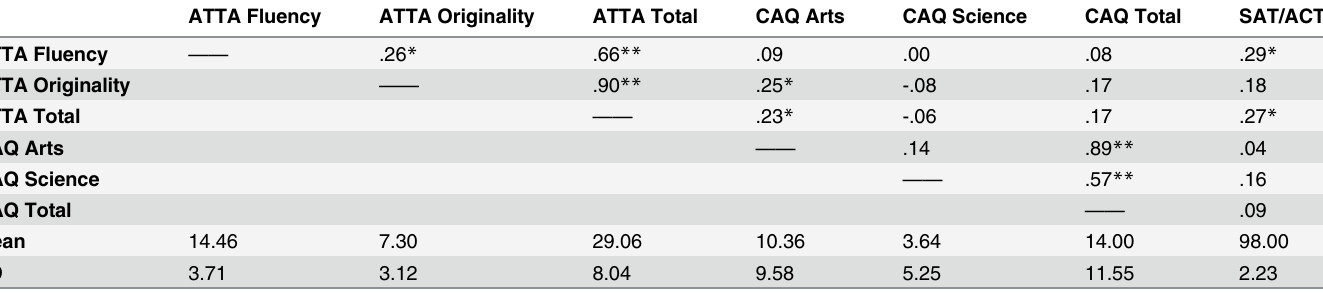
Table 1. Correlation matrix and descriptive statistics of ATTA fluency, ATTA originality, and ATTA total scores, CAQ arts, CAQ science, and CAQ total domain scores, and SAT/ACT scores. ATTA Fluency